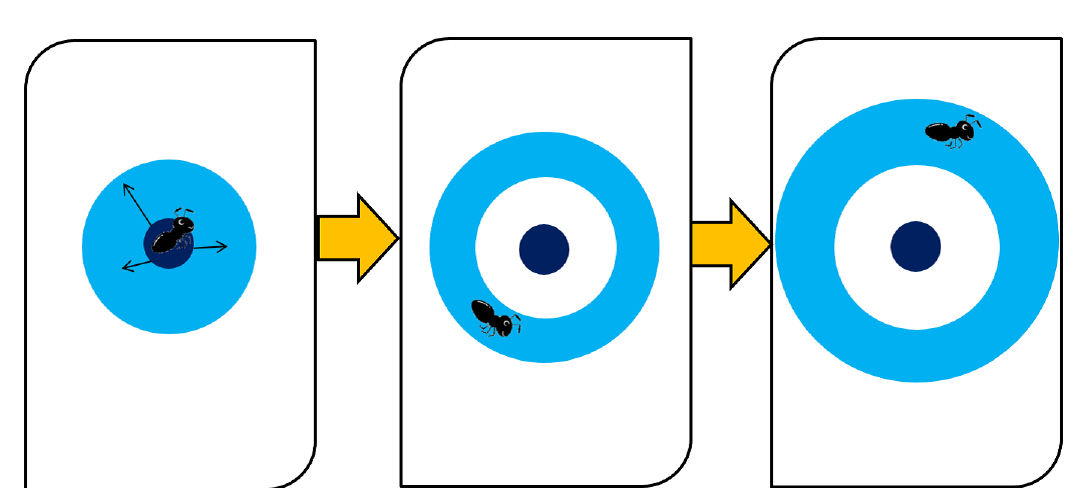
Figure 3. Missionary